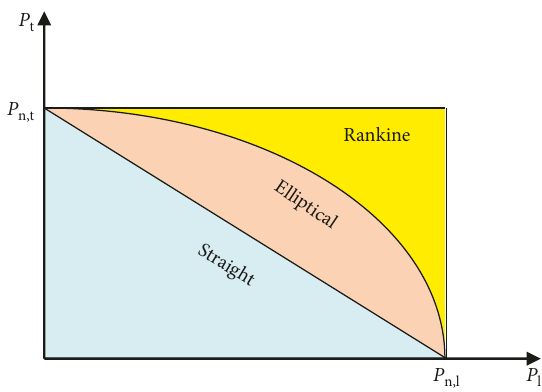
Figure 15: Failure criteria of biaxial shear for the anchor systems.